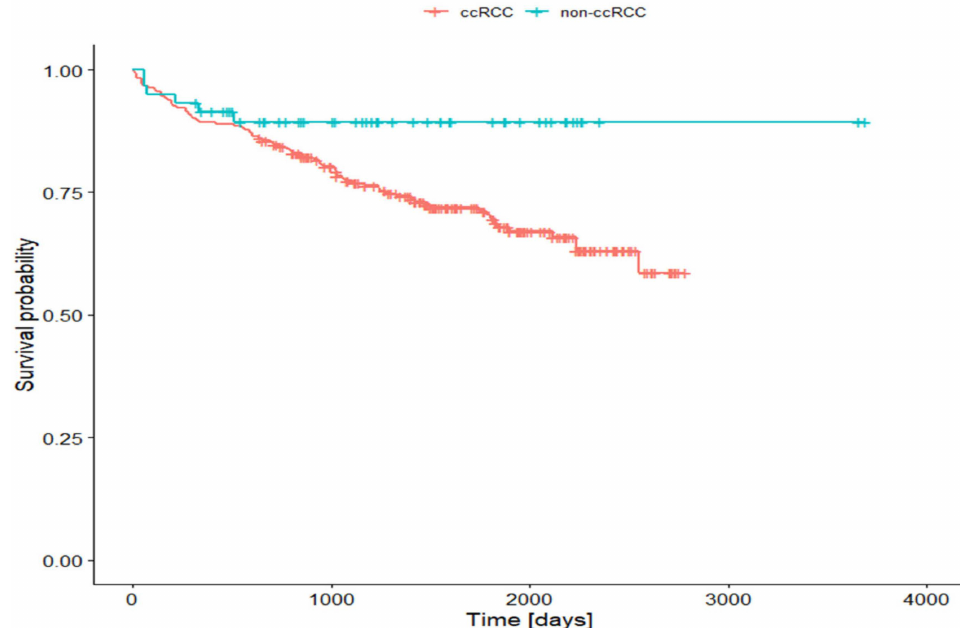
Figure 1. Kaplan–Meier survival curves according to the histopathological subtype of renal cell carcinoma. Patients with clear cell renal cell carcinoma had a significantly higher risk of death than patients with non-clear-cell renal cell